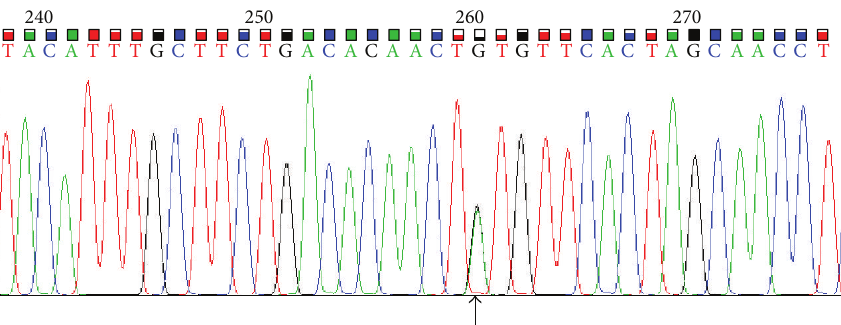
Figure 2: sequencing of beta globin gene showing location of +22 5UTR (G > A) mutation on beta globin